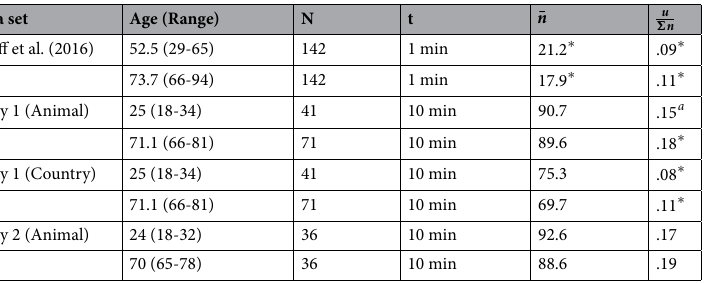
Table 1. An Overview of Fluency Data and their Inferred Macroscopic Network Structure. * Found to be significantly different between younger and older adults according to permutation tests; N = number of participants; t = time limit of the fluency task; ¯ n = average number of non-duplicate, valid responses per u individual; (cid:31) n = number of unique responses u divided by the sum of number responses n for all individuals in the